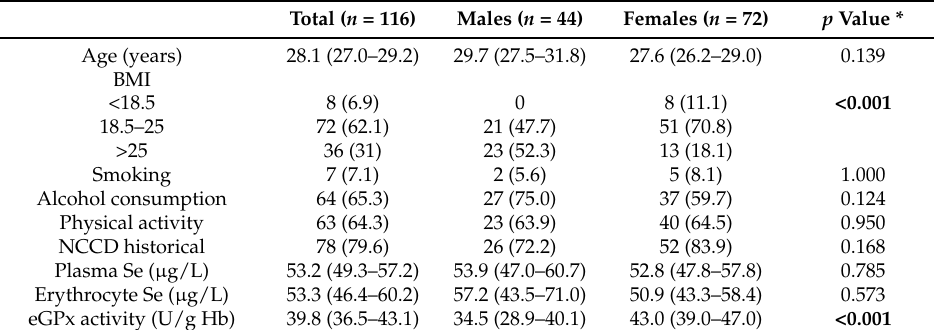
Table 1. Demographic and biochemical characteristics of the study